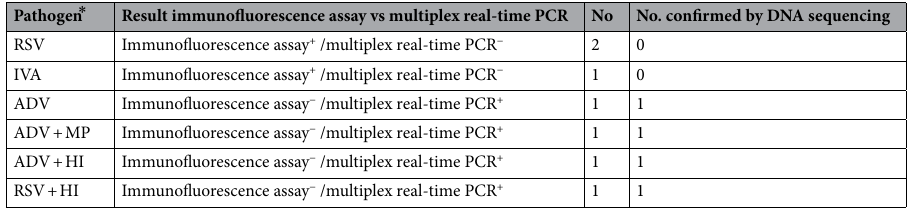
Table 4. Confirmation of Multiplex real-time PCR discordant specimens; pathogens detectable by both multiplex real-time PCR and immunofluorescence assays. ⃰ HI: Haemophilus influenzae , MP: Mycoplasma